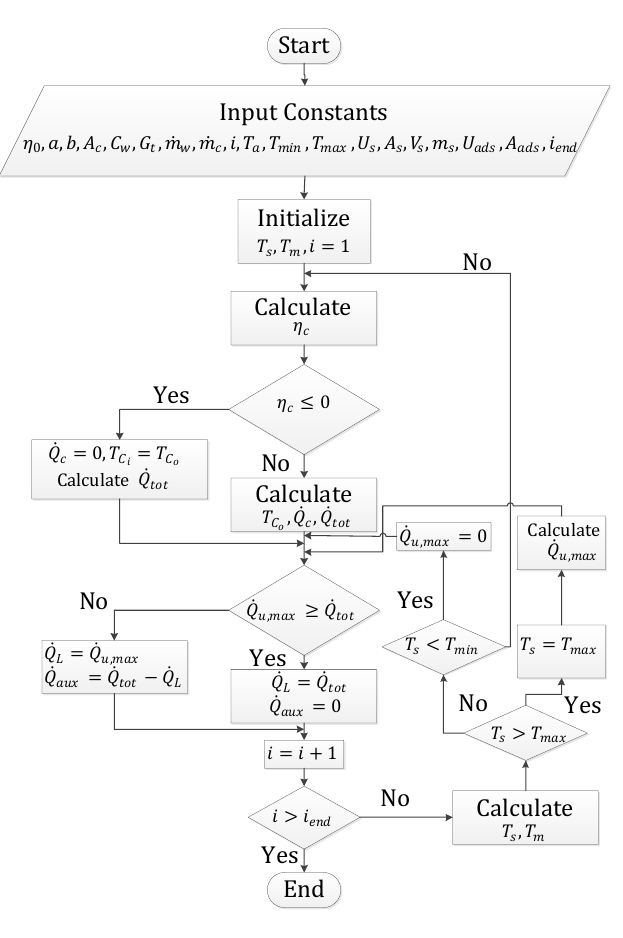
Figure 2. Flowchart of calculating required heat for the adsorption cooling system.